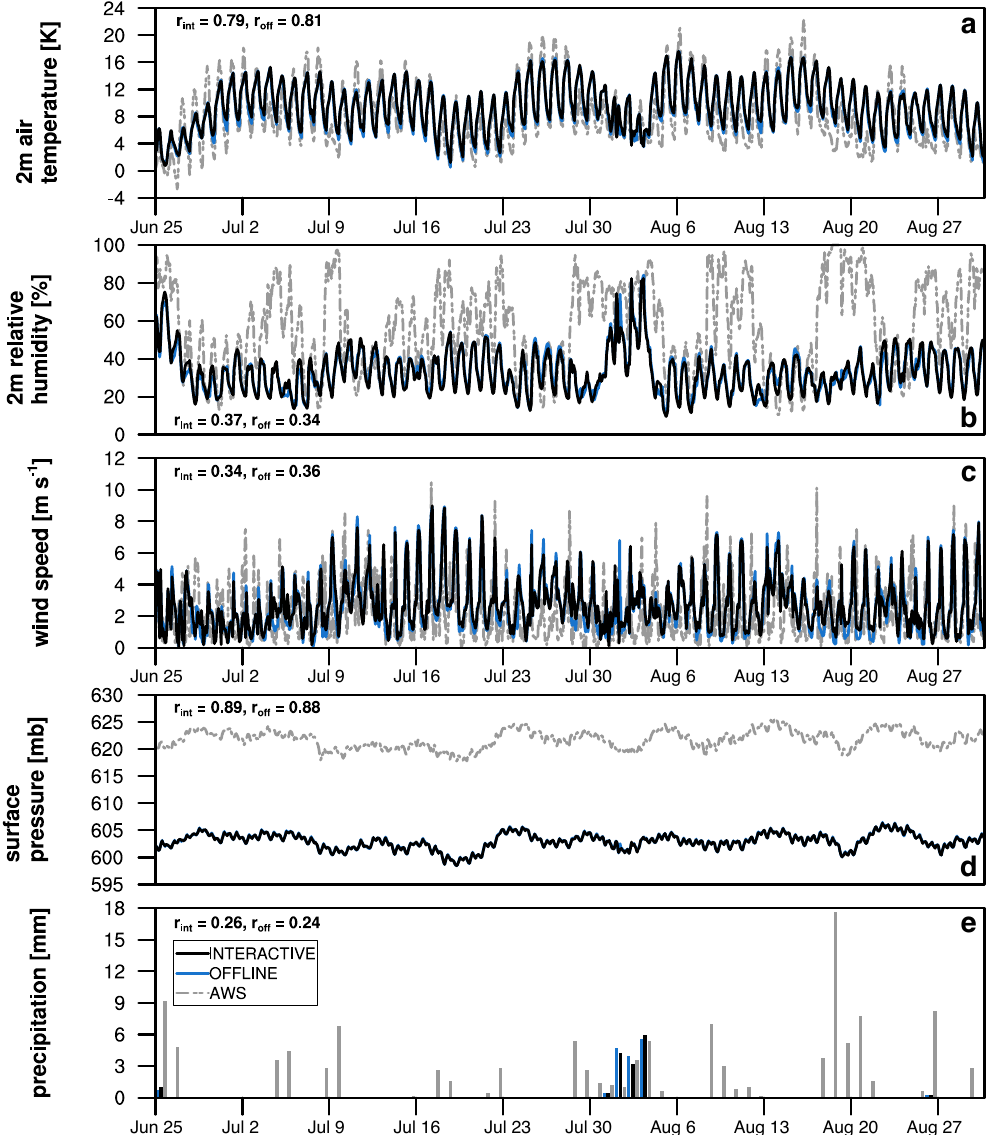
Fig. 3. Hourly (a) air temperature at 2m, (b) relative humidity at 2m, (c) wind speed at 10m, and (d) surface air pressure, as well as (e) daily total precipitation. Solid black (blue) curves display data from the interactive (offline) simulations while the dashed grey curve is the Urdukas AWS station data. Note the difference in elevation of the AWS (4022ma.s.l.) and the terrain height in the closest WRF grid cell